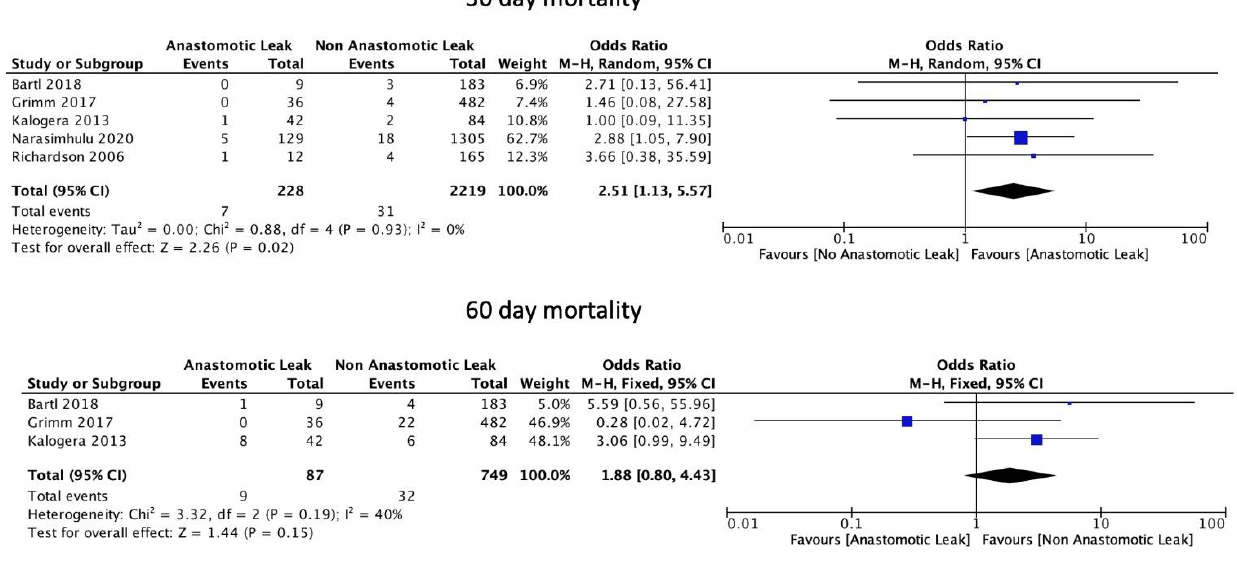
Figure 7. Mortality